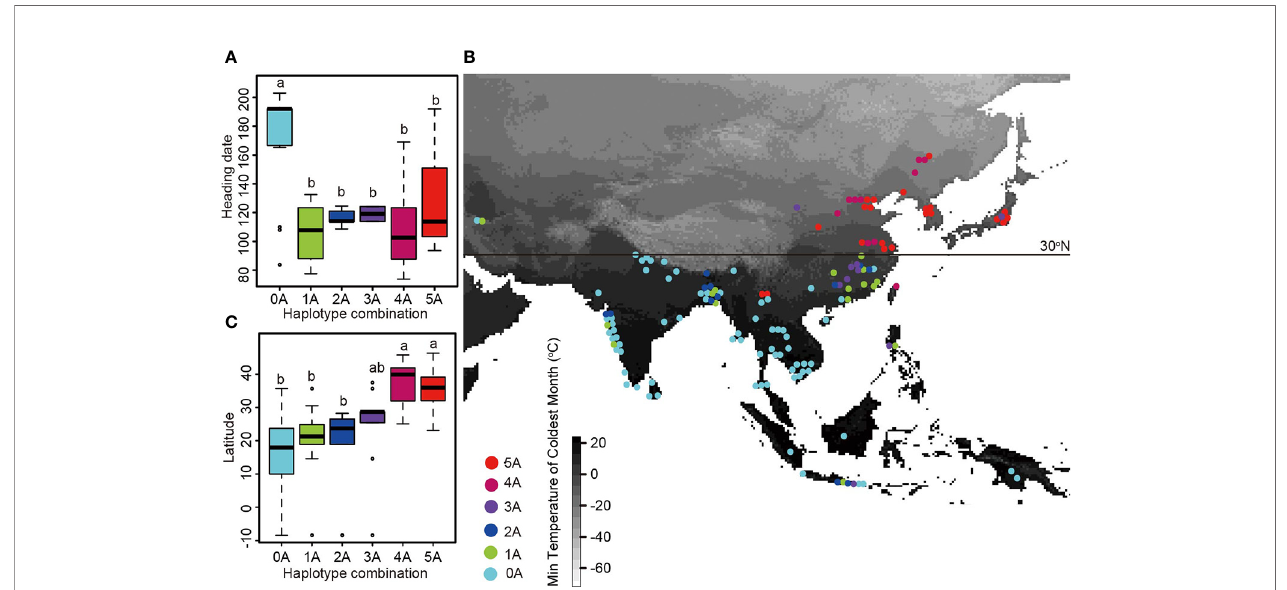
FIGURE 3 | The geographical distribution of haplotype combinations and the relationship between haplotype combination and heading date. (A) Boxplots of heading dates for samples with different haplotype combinations of fi ve long-day suppressor genes. Haplotype combinations containing between zero and fi ve group A haplotypes are shown on the x -axis. (B) Geographical distribution of haplotype combinations of fi ve long-day suppressor genes. Haplotype combinations containing between zero and fi ve group A haplotypes are indicated by dots of different colors. The map is shaded to indicate the minimum temperature of the coldest month, with lower minimum temperatures in white and higher minimum temperatures in black. (C) Boxplots of latitude data for samples with different haplotype combinations of fi ve long-day suppressor